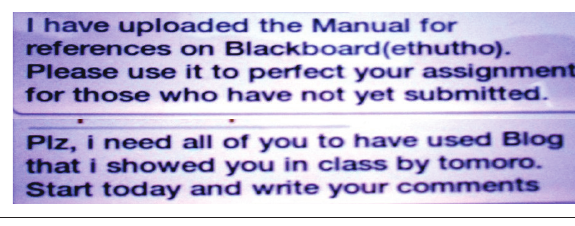
FIGURE 3: Example of lecturer’s functioning.